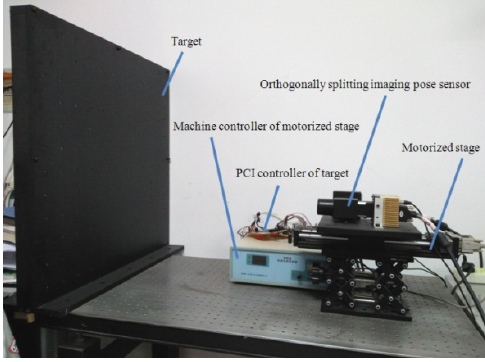
Figure 4. Experimental apparatus.